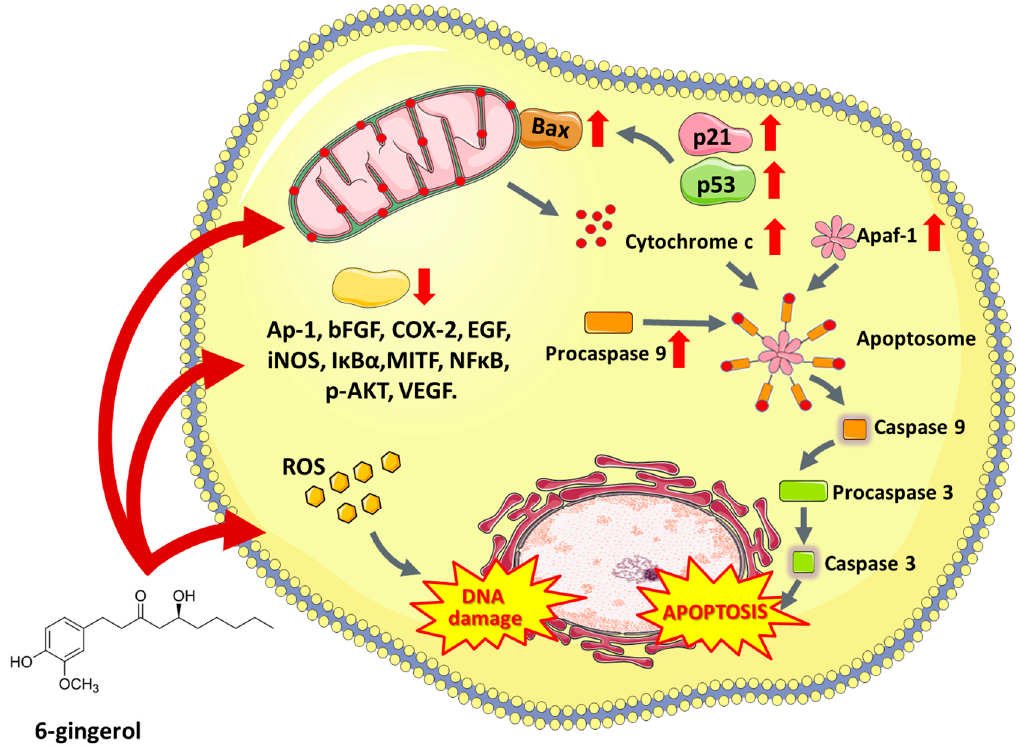
Figure 3. The multi-level effect of 6-gingerol (5-hydroxy-1-(4 (cid:48) -hydroxy3 (cid:48) -methoxyphenyl)-3-decanone) on cancer cells. Apaf-1—Apoptotic protease activating factor, Ap-1—Activator protein 1, Apaf-1—Apoptotic protease activating factor 1, Bax—BCL2 associated X protein, bFGF—basic fibroblast growth factor, COX-2—Prostaglandin-endoperoxide synthase 2, EGF—Epidermal growth factor, iNOS—Nitric